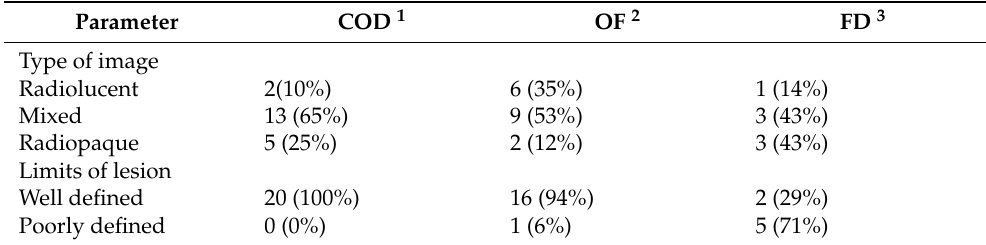
Table 3. Distribution of radiological features ( n , %) for each fibro-osseous lesion subtype.